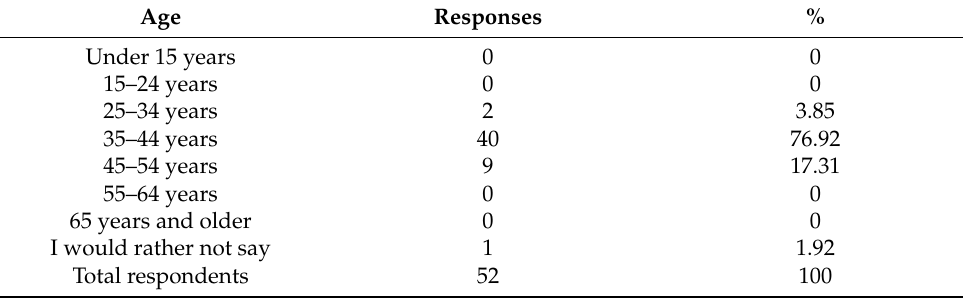
Table A2. Age distribution of survey